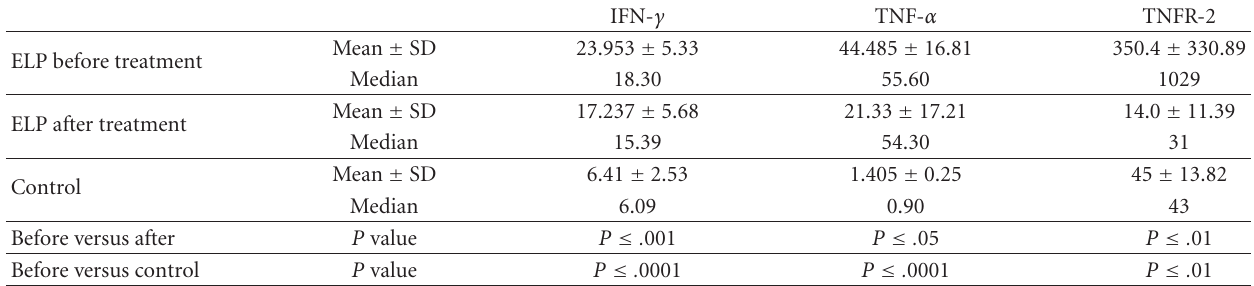
Table 2: The change of IFN- γ , TNF- α , and TNFR-2 salivary levels in ELP patients treated with prednisone and control subjects.